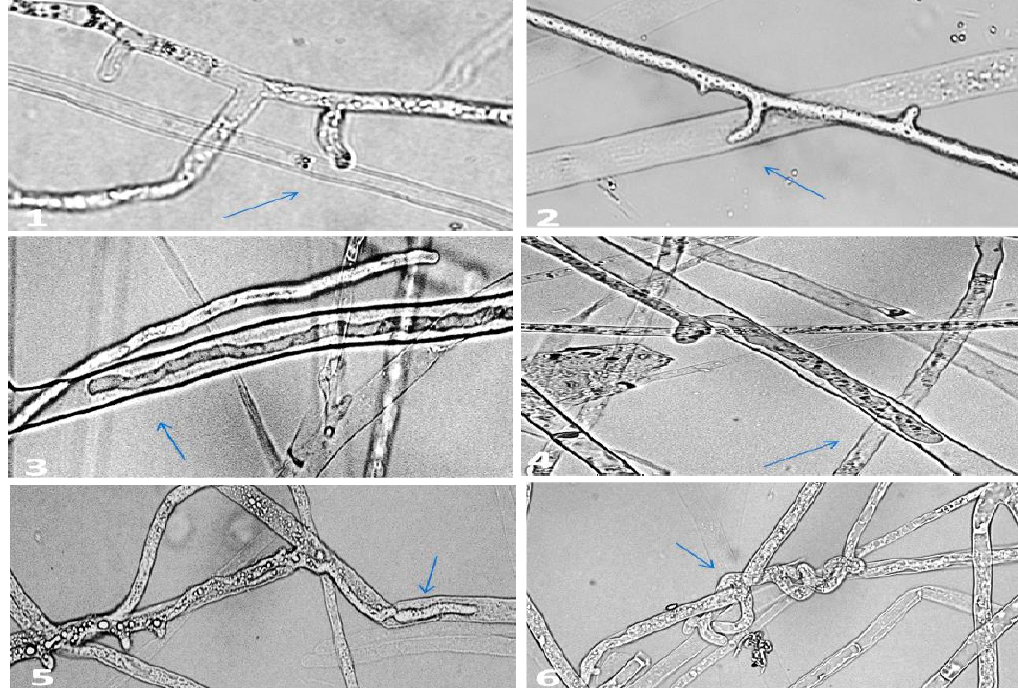
Figure 2. Hyphal interactions between P . oligandrum ( MS15 ) and P . aphanidermatum using a light microscope: ( 1 ) and ( 2 ) showing infection pegs of P. oligandrum ; ( 3 ) and ( 4 ) showing hyphae of P . oligandrum grow inside hyphae of P . aphanidermatum ; ( 5 ) and ( 6 ) arrows pointed to P. oligandrum twisted on hyphae of P . aphanidermatum .